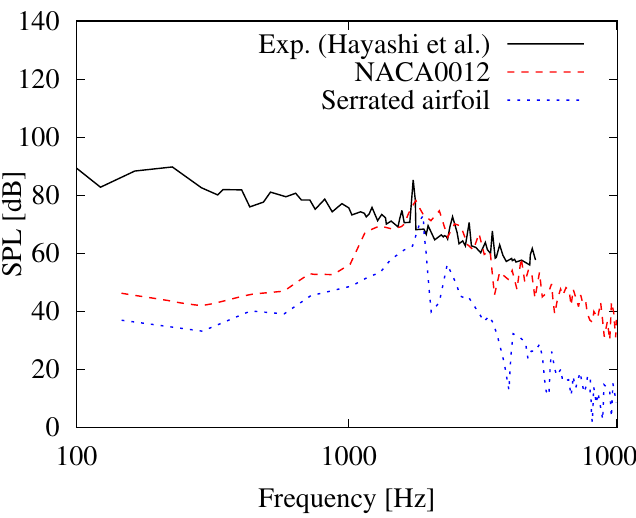
Figure 15. Averaged friction coefficients on the suction side of NACA0012